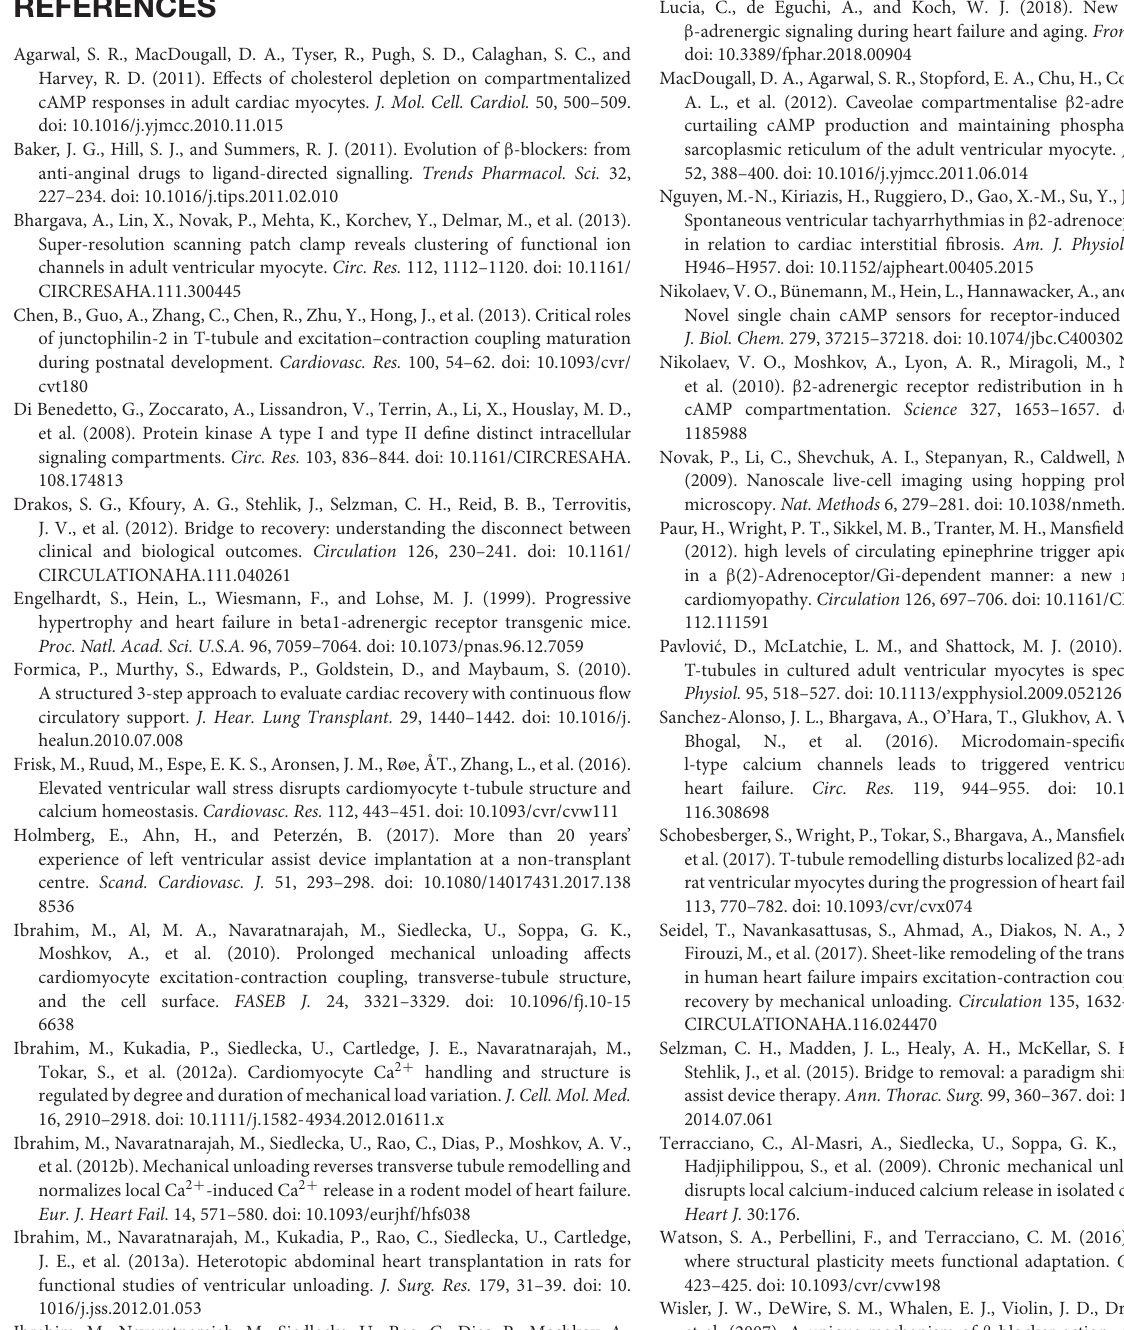
di8ANNEPPS staining in loaded and unloaded cardiomyocytes (freshly isolated cells). (E) Graph comparing the ratio of cell length vs. width in loaded and unloaded cardiomyocytes (freshly isolated cells). (F) Graph comparing the cell area of loaded and unloaded cardiomyocytes (freshly isolated